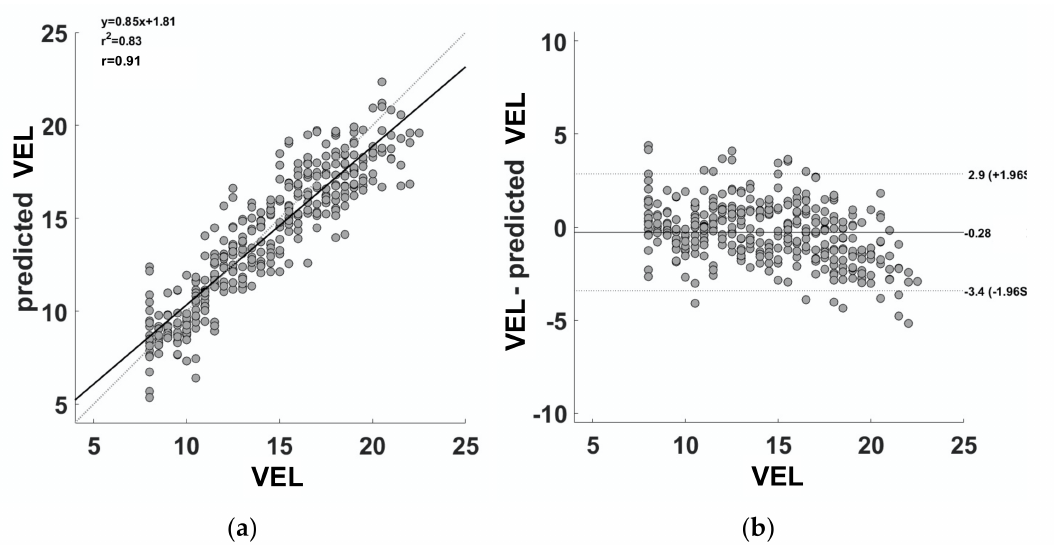
Figure 4. The figure reports the correlation ( a ) and the Bland-Altman ( b ) plots obtained between the estimated and the known velocities. VEL = velocity.